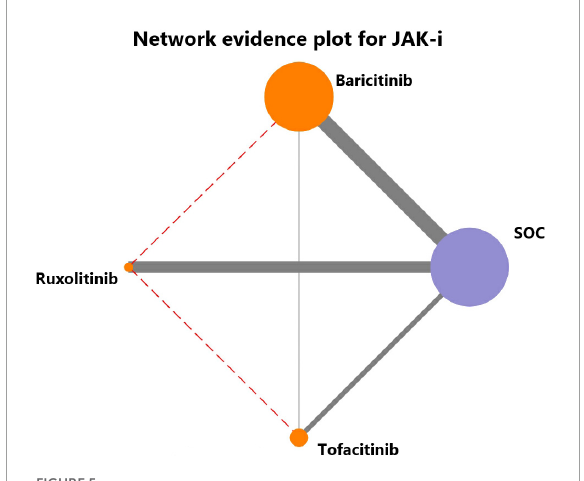
FIGURE5 Network evidence for JAK inhibitors to treat COVID-19. The thickness of connecting lines represented the number of trials between each comparator, and the size of each node corresponded to the number of participants who received the same intervention (sample